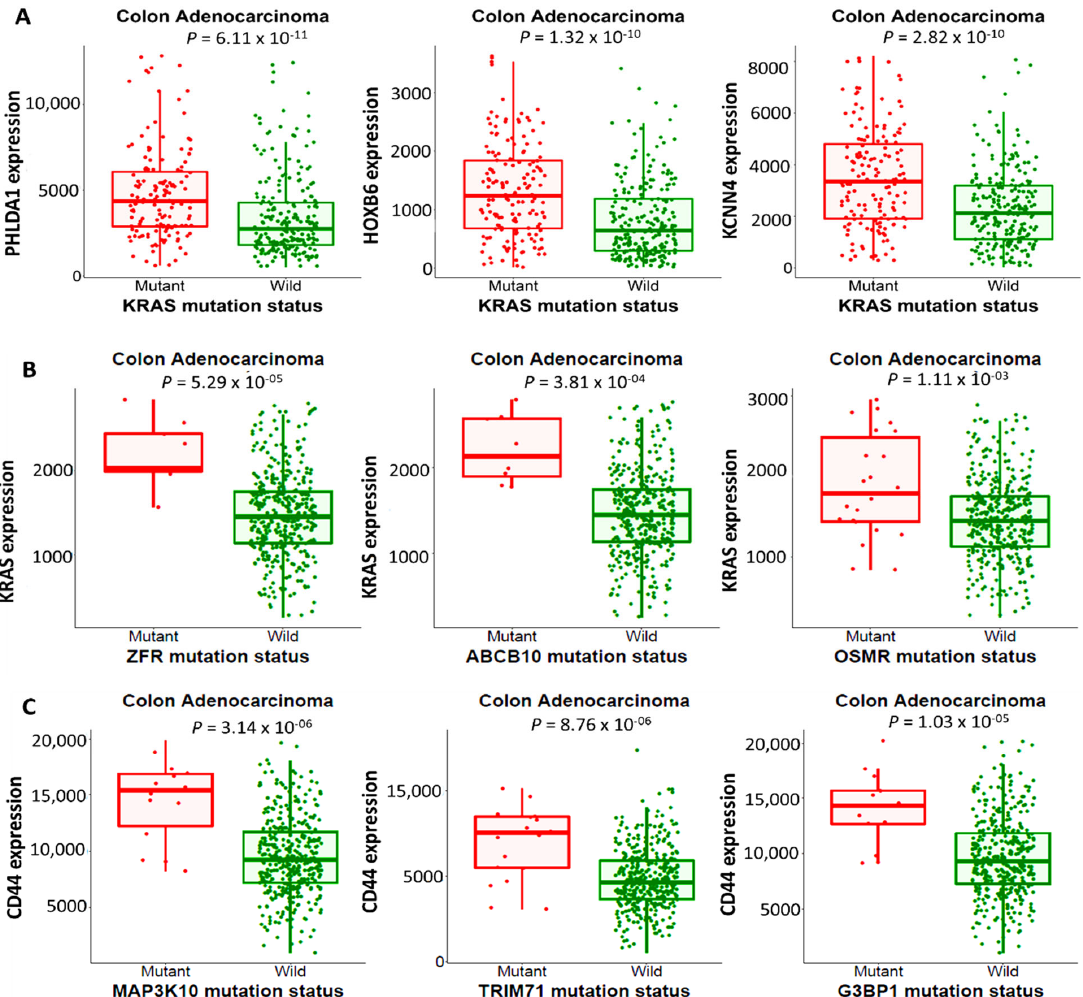
Figure 3. KRAS and CD44 mutations were associated with worsened clinical outcomes in colorectal cancer (CRC). ( A ) Associations of KRAS mutations with the top three highly expressed genes ( PHLDA1 , HOXB6 , and KCNN4 ) in CRC. ( B , C ) The top three genes ( ZFR , ABCB10 , and OSMR ) for KRAS and ( MAP3K10 , TRIM71 , and G3BP1 ) for CD44 had stronger mutations and were associated with changes in expressions of KRAS and CD44 in CRC, with p < 0.05 considered significan